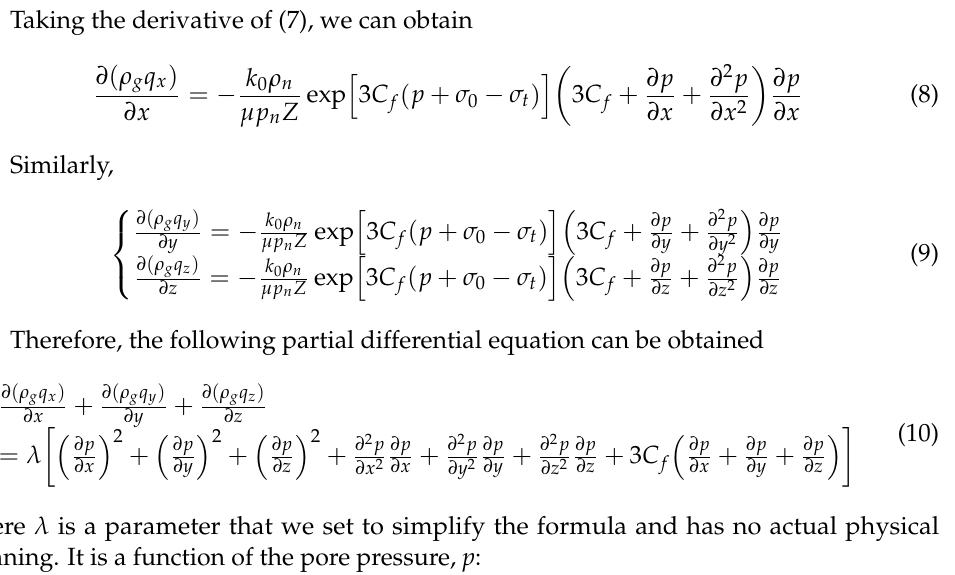
Figure 3. The methane viscosity testing results by Lee (1965) [34], Diehl et al. (1970) [35], and Stephan and Lucas (1979) [36], respectively.